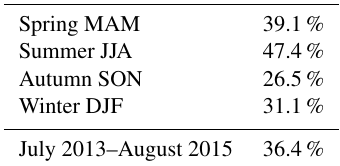
Table 1. Data capture of 1h values recorded for FCH 4 in the